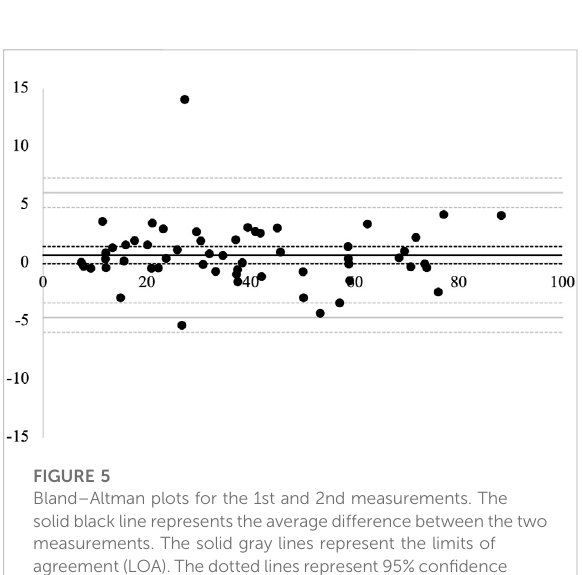
FIGURE 5 Bland – Altman plots for the 1st and 2nd measurements. The solidblack line representstheaveragedifference between thetwo measurements. The solid gray lines represent the limits of agreement(LOA).The dotted linesrepresent 95% con fi dence